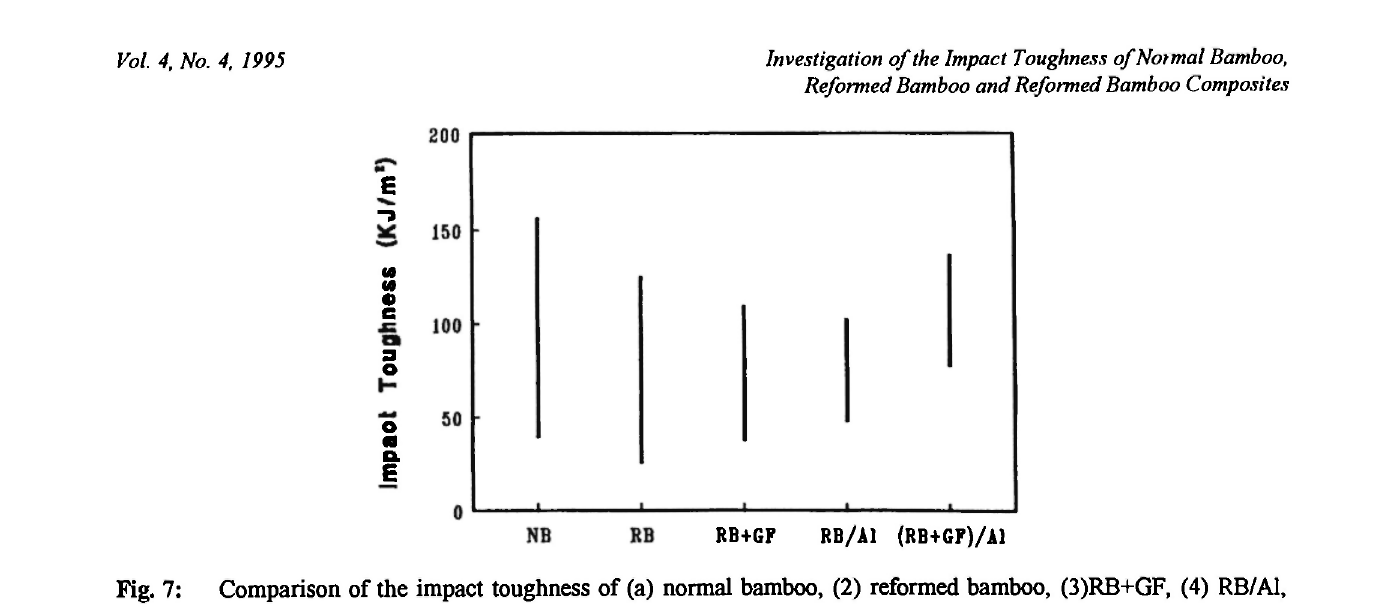
Fig. 7: Comparison of the impact toughness of (a) normal bamboo, (2) reformed bamboo, (3)RB+GF, (4) RB/A1, (5)